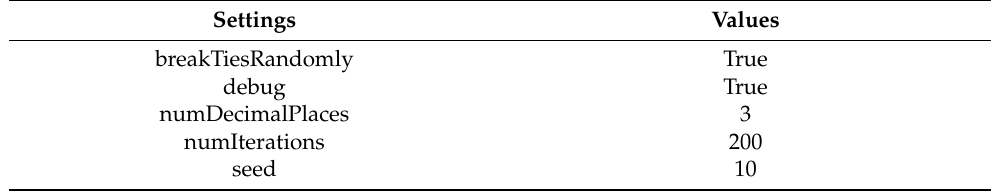
Table 10. The settings of the ensemble learning using Random Forest method. Settings Values breakTiesRandomly True debug True numDecimalPlaces numIterations